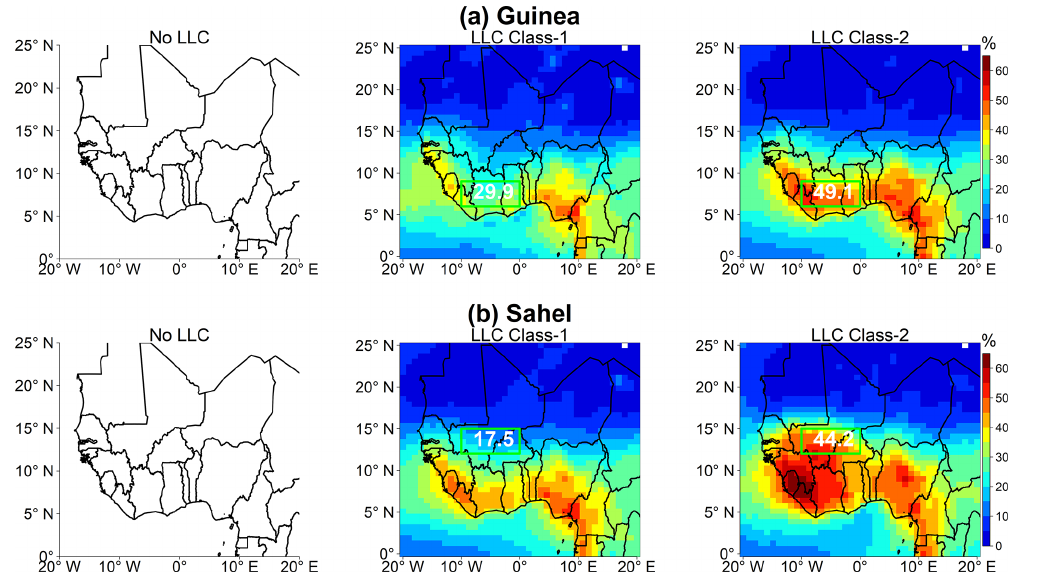
Figure 10. Mean attenuation of incoming downwelling shortwave radiation (%) during JAS from 2006 to 2015 over WA for the occurrence of the three LLC classes in the Guinea (a) and Sahel (b) regions. Only occurrences that last for at least 6 consecutive hours are considered. Numbers in the box refer to the mean percentage attenuation of incoming shortwave radiation in that specific area. No event of the No LLC class has been extracted in the Guinea and Sahel regions during JAS, hence the empty plots.